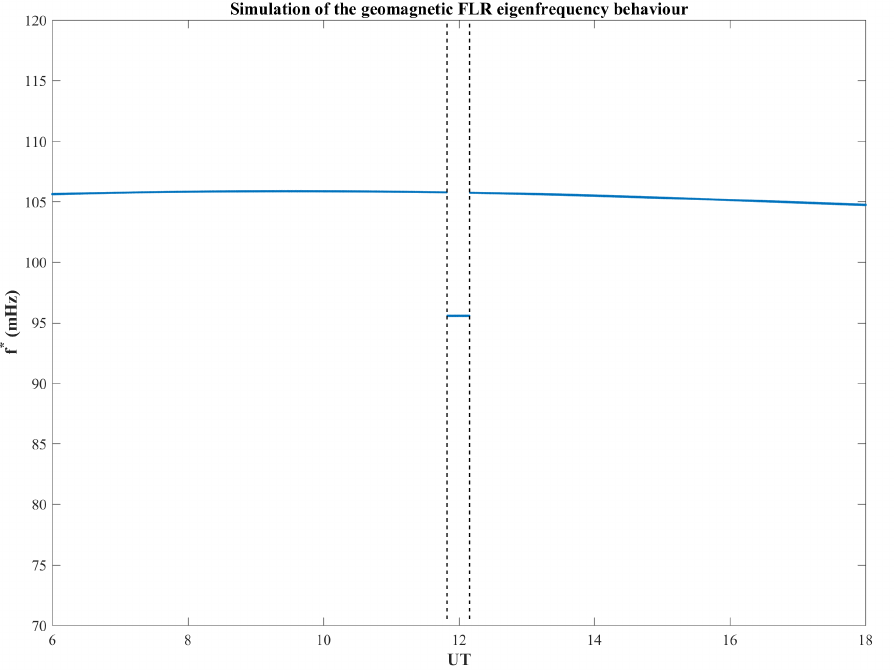
Figure 4. As an example, in the Figure, is shown the simulated behaviour of the FLR eigen-frequency obtained by our modeled for a potential EQ occurred at 20 ◦ magnetic